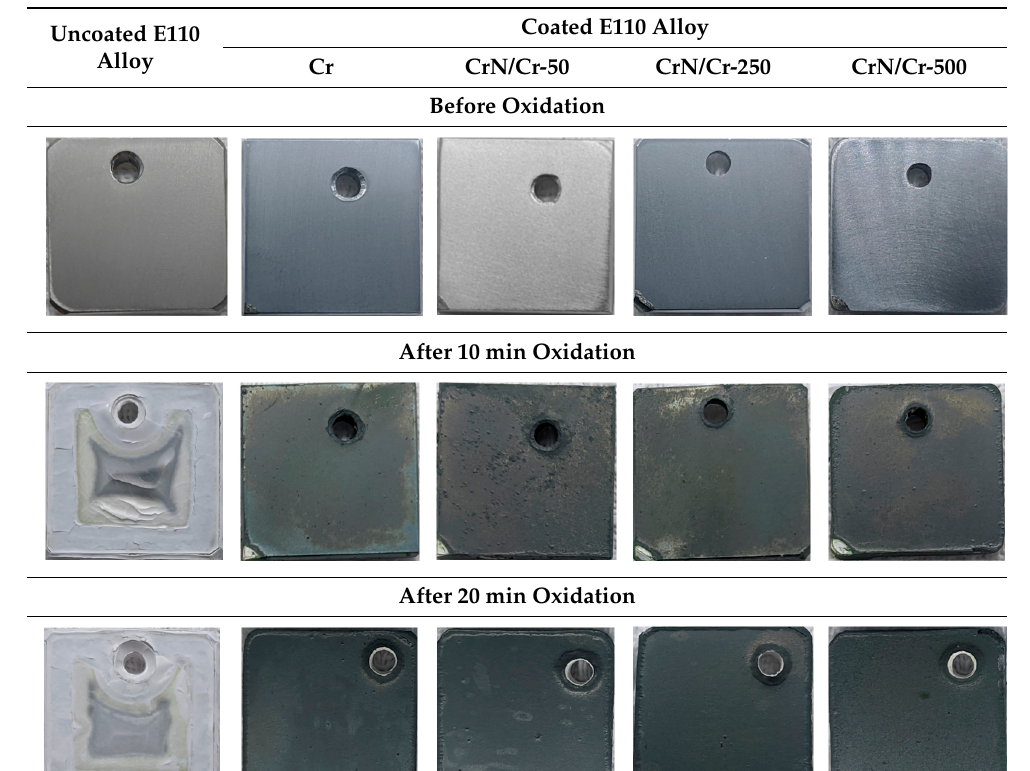
Table 2. The samples before and after oxidation.